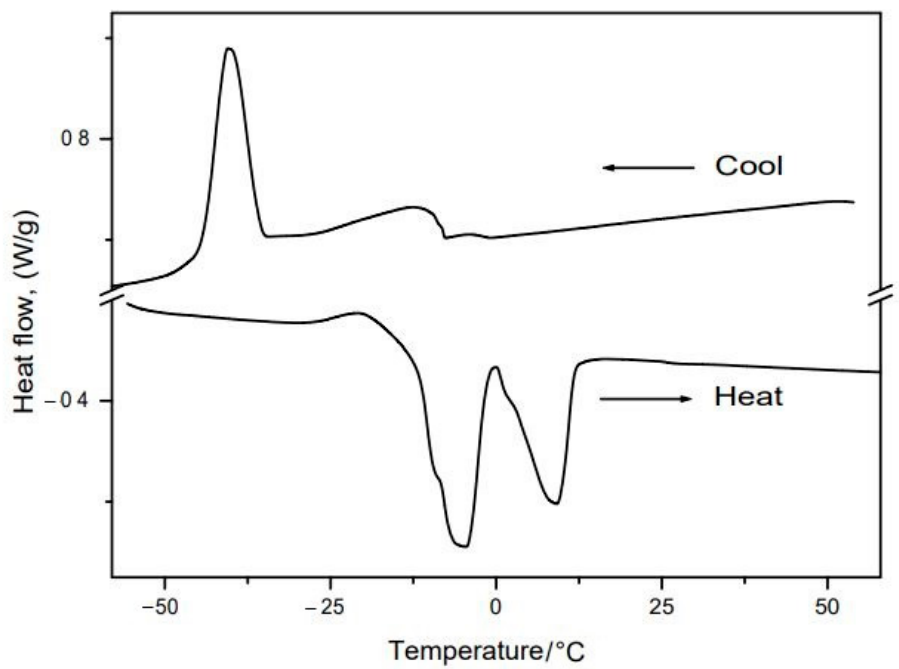
Figure 6. DSC curves of buriti oil with fusion point ( bottom ) and crystallization point ( top ). Figure 6. DSC curve s of buriti oil with fusion point (bottom) and crystallization point (top).